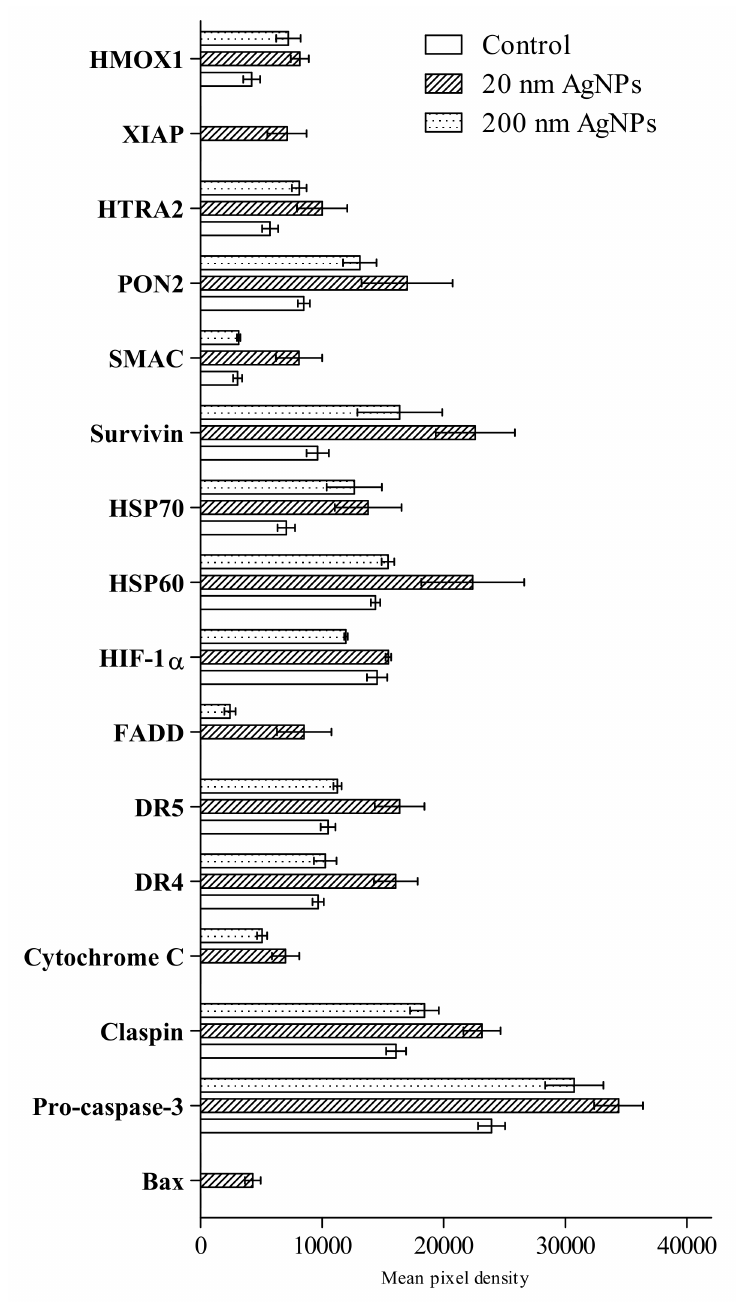
Figure 3. Semi-quantitative assessment of apoptosis markers in MDA-MB-436 cells after incubation with 20 or 200 nm AgNPs measured by the Proteome Profiler Human Apoptosis Array Kit in a mixture of cells lysates from three independent experiments. Untreated cells were used as a control. Apoptosis markers levels were presented as the mean with the range of two individual measurements, normalized to reference spots and the negative control (film background) was